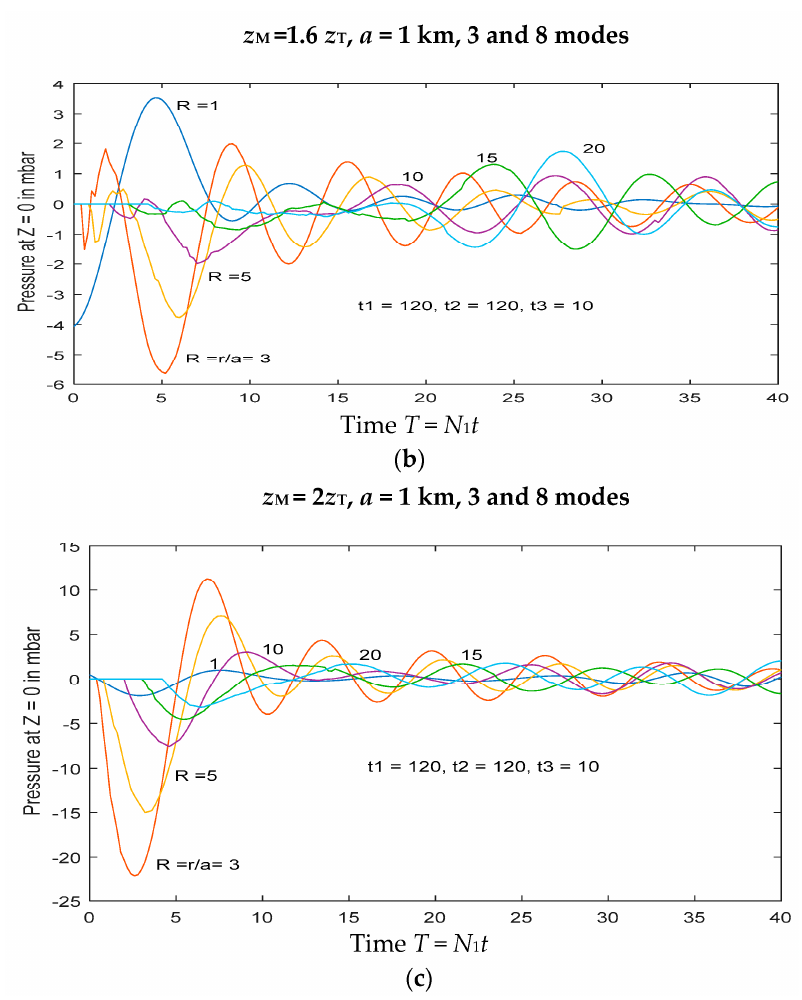
Figure 8. Total surface pressure signals from eruptions that extend into the stratosphere: ( a ) z M = 1.2 z T ; ( b ) z M = 1.6 z T ; and ( c ) z M = 2 z T . Parameter values are mostly similar to preceding figures: a = 1 km, N 1 = 0.012 s − 1 , N 2 = 0.024 s − 1 , and the forcing grows at a uniform rate for 2 min ( t 1 = 120 s), and